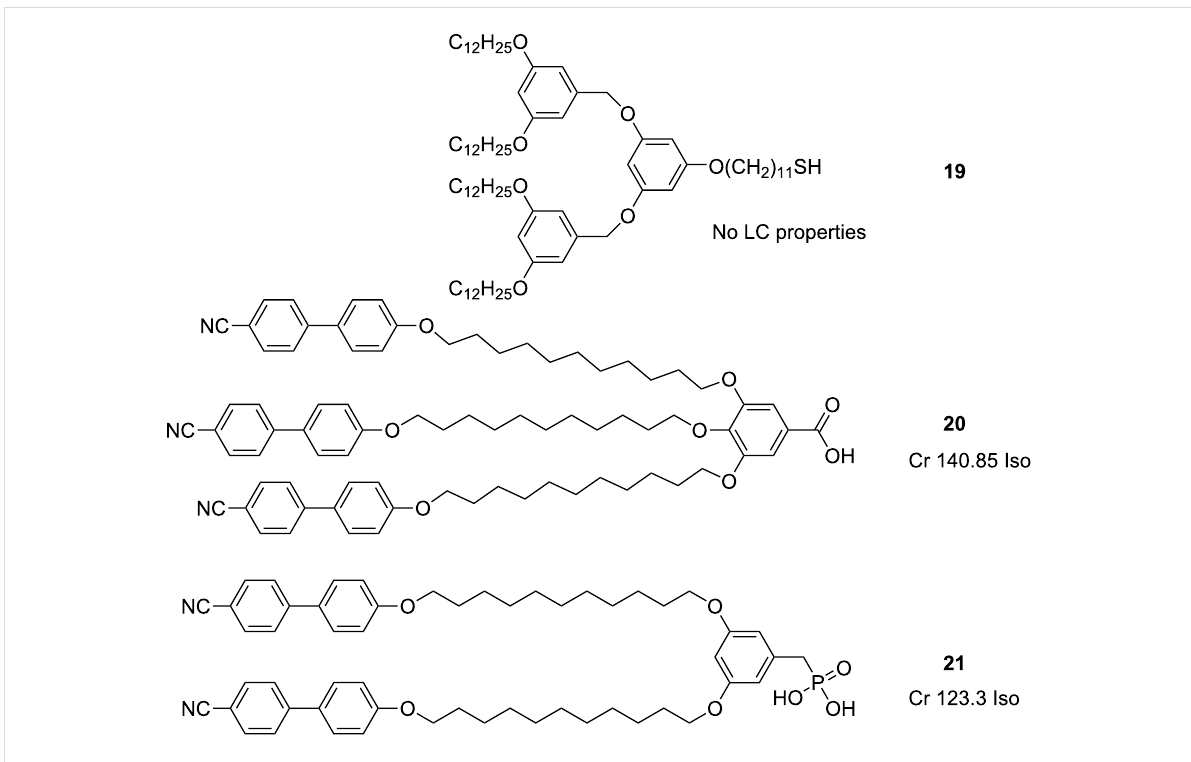
Figure 21: Chemical structures and mesogenic properties of dendritic and proto-dendritic ligands used to coat